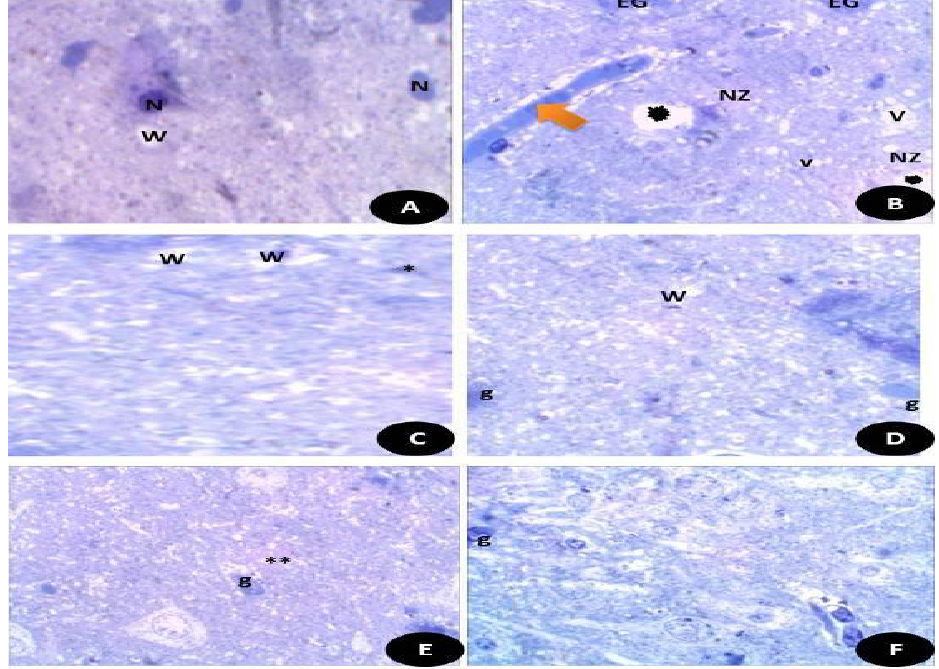
Figure 15. Semi thin sections of the brain tissues stained with toluidine blue stain. ( A ) Control, normal appearance of brain tissues with normal white matter (W) and neurons (N). ( B ) DG- treated rats showed highly necrotic zone (NZ) and enlarged swollen glial fibers (EG) with vacuoles (V) and some detached areas (Black star). ( C ) Q treated group showed normal appearance of brain tissues with normal white matters (W) and small glial fibers (*). ( D ) Ru III /Q treated animals showed normal appearance of brain tissues with normal white matters (W) and glial fibers ( E ). DG + Q group showed that the brain tissues had reduced necrotic zone (**) and normal moderate sized glial fibers (g). ( F ) DG + Ru III /Q group showed the brain tissues with nearly normal appearance and mostly normal glial fibers and some swelled glial fibers with almost normal neural fibers.